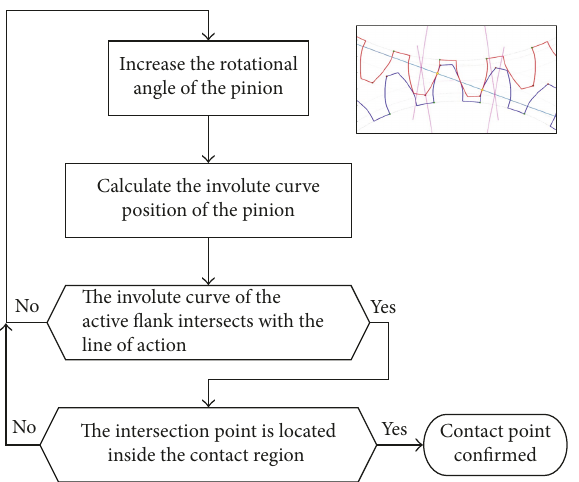
Figure3:Programmingflowchartfordeterminingthecontactpoints between two meshing gears.